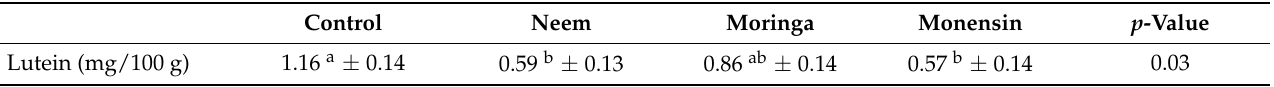
Table 3. The effect of dietary inclusion of neem ( Azadirachta indica) and moringa (Moringa oleifera) on the lutein concentrations in the subcutaneous fat of SA Mutton Merino lambs. Control Neem Moringa Monensin p -Value Lutein (mg/100